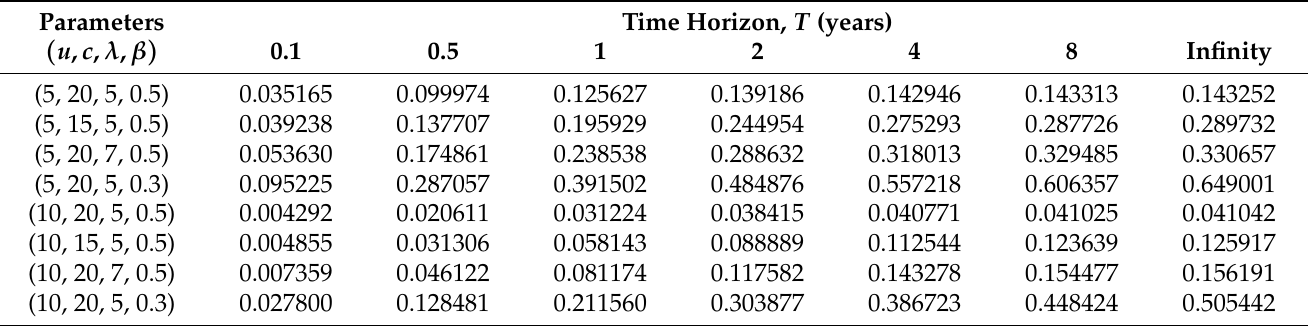
Table 2. Finite and infinite-time ruin probability under different parameter settings. For the pa- rameters, u is the initial capital, c is the premium rate, λ is the claim intensity, and 1/ β is the mean claim